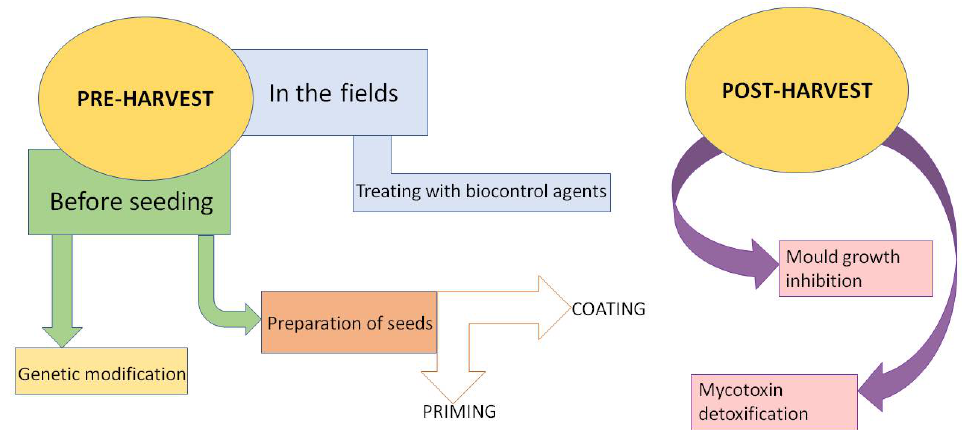
Figure 1. Pre-harvest and post-harvest methods of biocontrol of cereals -populating mycotoxins.